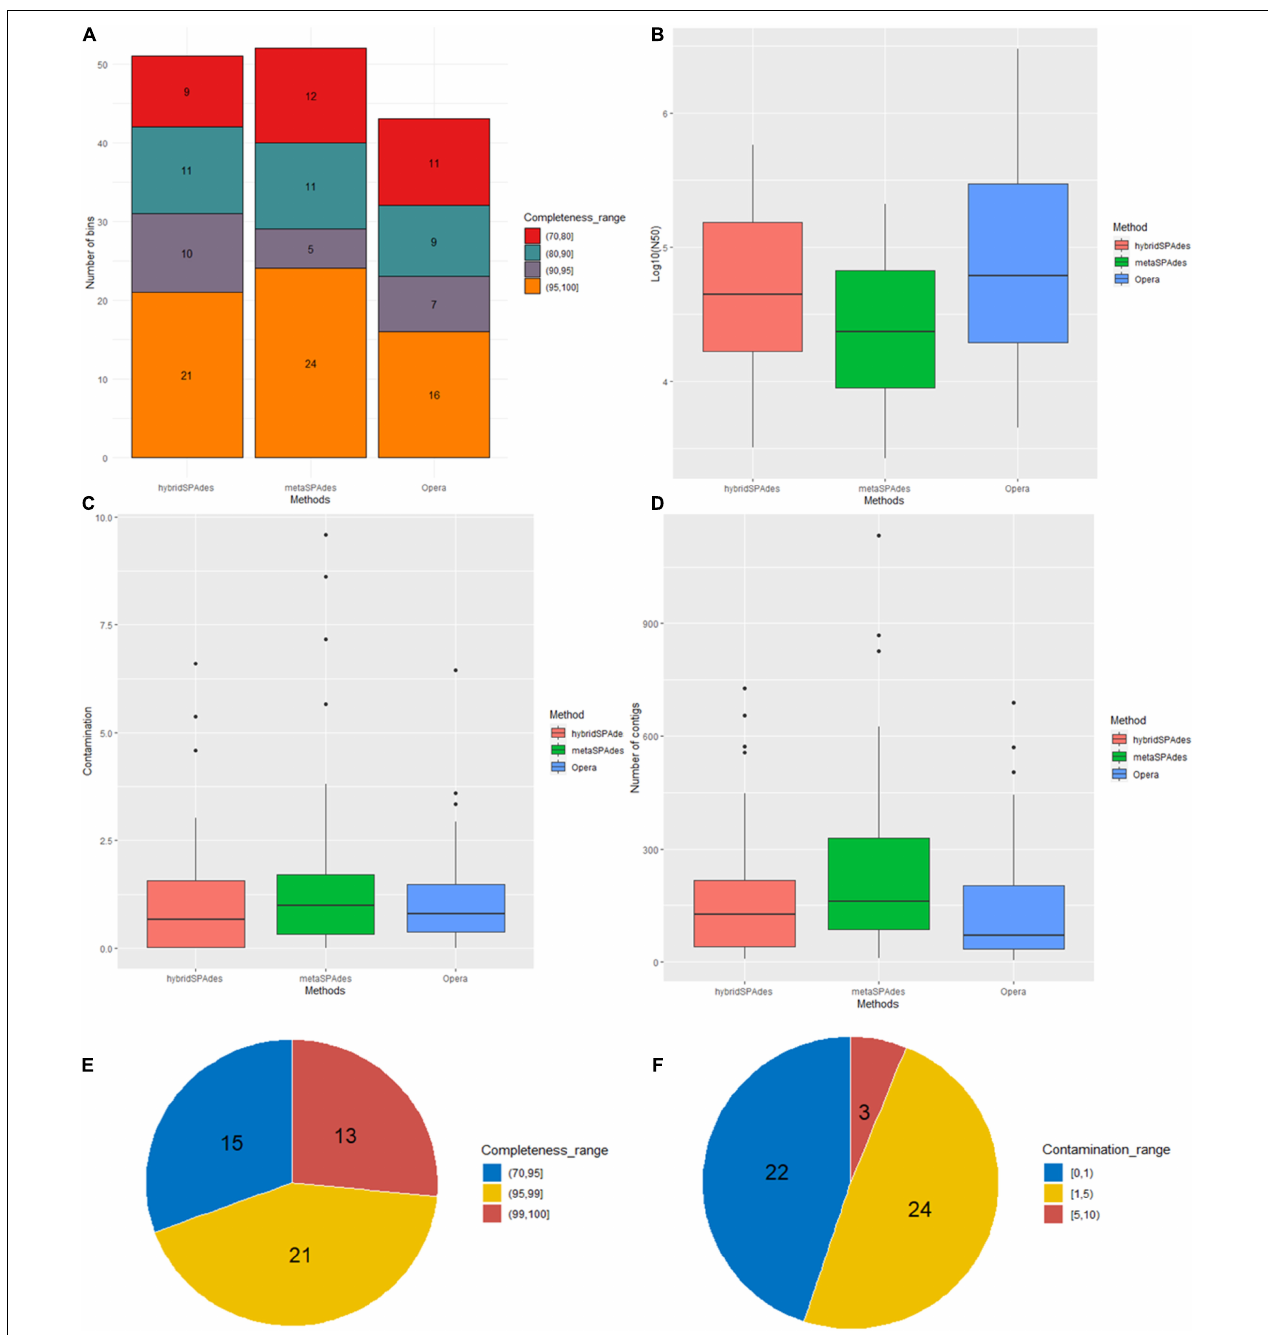
FIGURE 5 | Binning statistics of genome assembly with different algorithms (metaSPAdes, hybridSPAdes, and OPERA-MS). (A) Number of genome bins with different completeness ( > 95%, 90–95%, and 70–95%). (B) log10 N50 of the genome bins. (C) Contamination percentages (%) of the genome bins. (D) Distribution of number of contigs in each bin. Distribution of completeness (E) and contamination (F) of metagenome bins after dereplication.